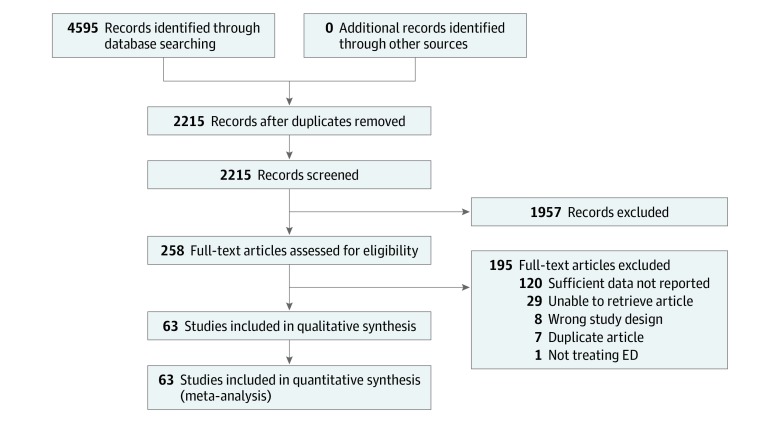
Flowchart for the Trials Included in the Meta-analysisED indicates erectile dysfunction.